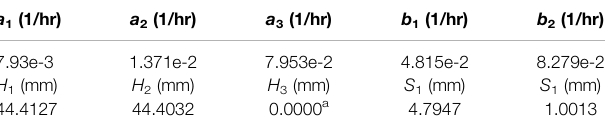
TABLE 2 | Calibrated tank model parameters for the 2009 SiangYang landslide.